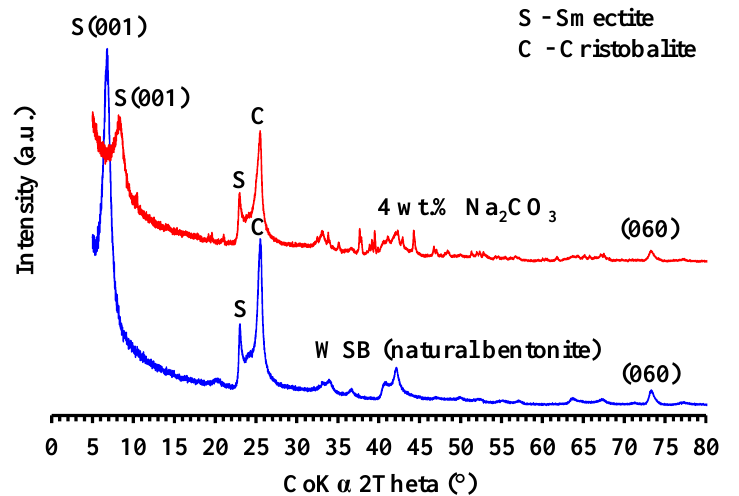
Figure 1. XRD patterns for the raw wet sieved bentonite (WSB) and 4 wt.% Na 2 CO 3 -modified sam- ple.